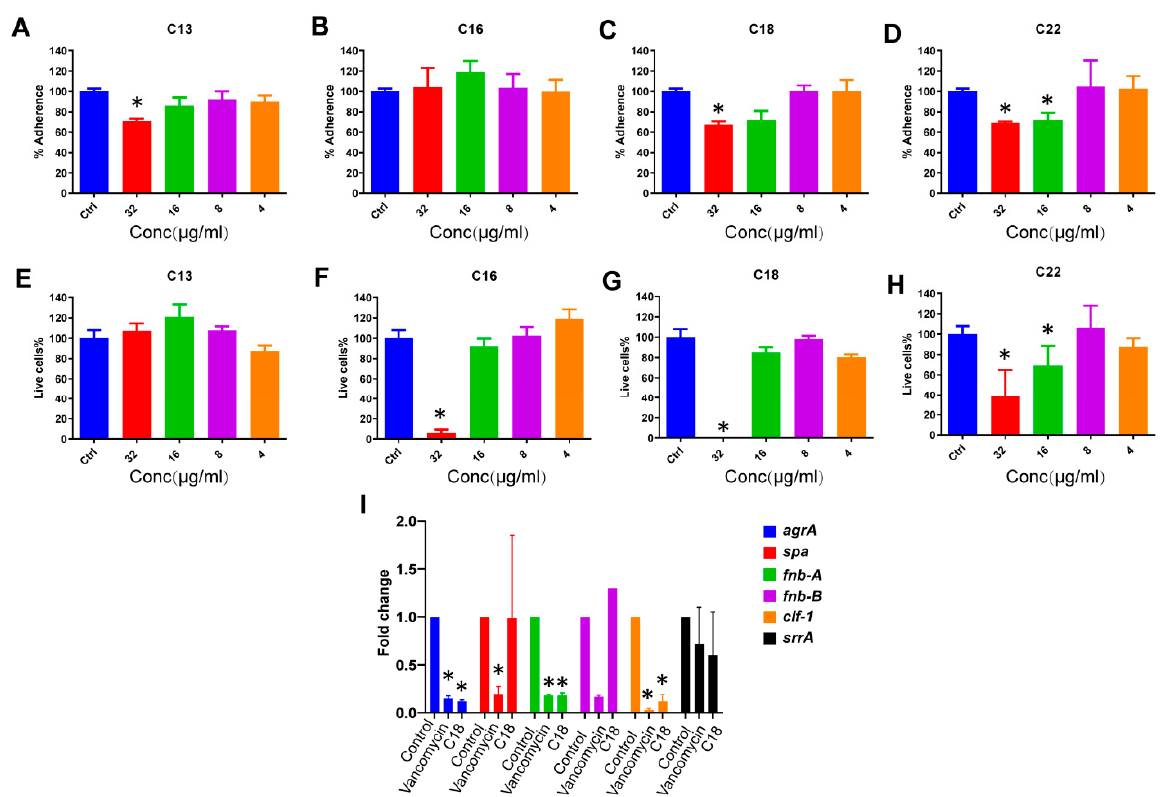
Figure 3. The antibiofilm effects of Cec4-derived peptides. ( A – D ) The potential of peptides to inhibit S. aureus MW2 biofilm attachments. ( E – H ) The inhibition of S. aureus MW2 biofilm formation. ( I ) S. aureus MW2 cells were treated with C18 (2 µg/mL) for 4 h. Exposure to C18 was associated with down-regulation of major virulence regulator genes, including agrA, fnb-A, and clf-1. Data represent the mean ± SD (n = 3). * p < 0.05, Student’s t-test compared with PBS control.